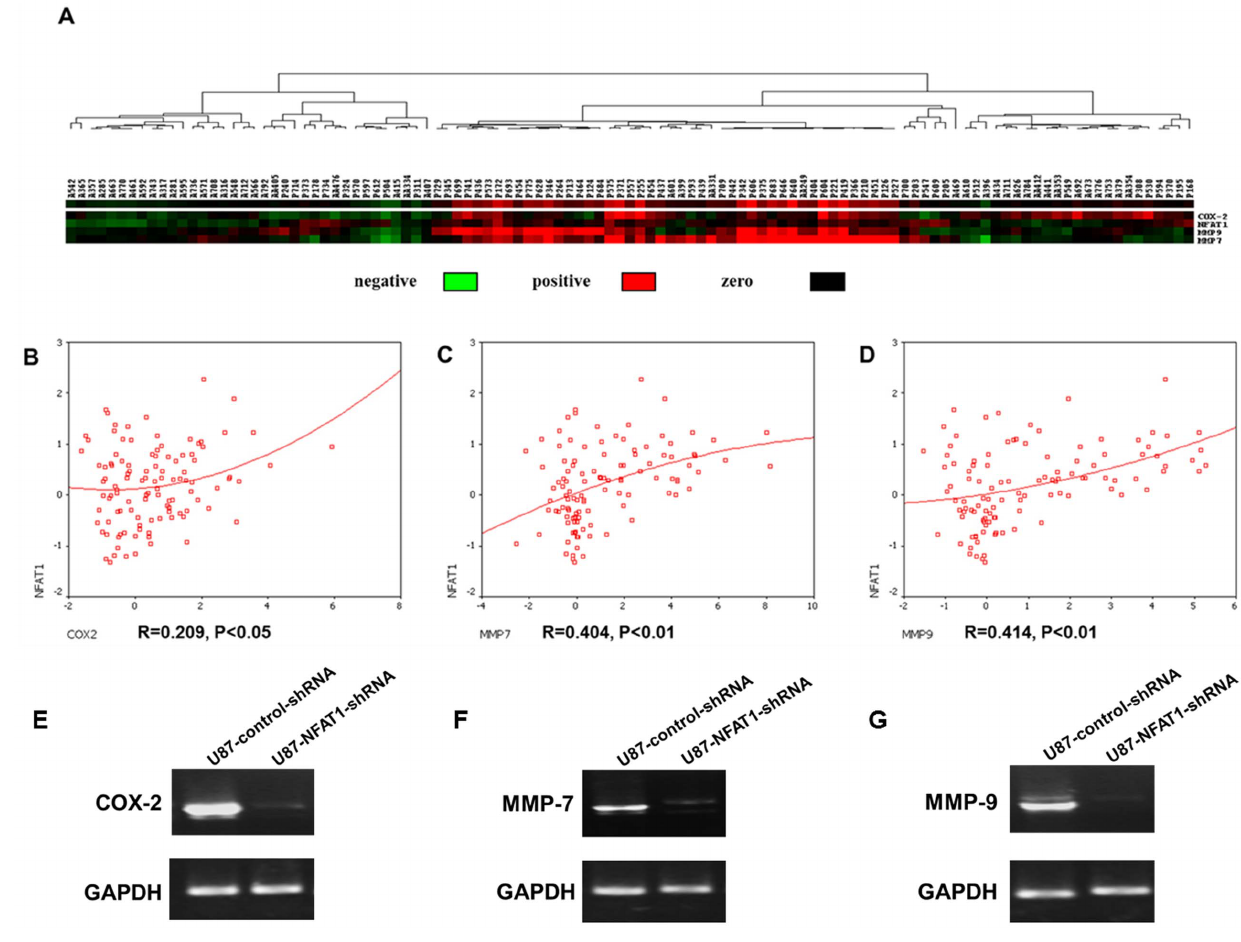
Figure 5. The mRNA expression of NFAT1, COX-2, MMP-7 and MMP-9 obtained from microarray analysis in 111 clinical samples was analyzed by cluster analysis and Pearson correlation analysis. (A) Cluster Treeview showed that high co-expression of NFAT1, COX-2, MMP-7 and MMP-9 was only found in GBM samples. (B, C and D) Correlation between the expression of NFAT1 and the expression of COX-2, MMP7 and MMP-9 E-F: RT-PCR demonstrated that NFAT1 knockdown by specific shRNA resulted in a significant reduction of COX-2, MMP-7 and MMP-9 mRNA expression.